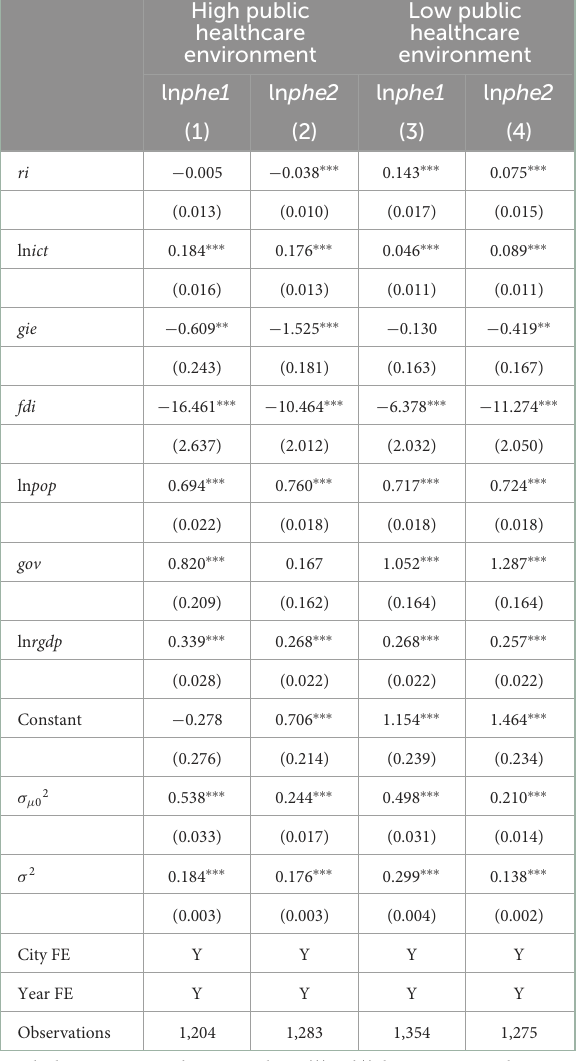
TABLE 6 Heterogeneity analysis of different public healthcare environment